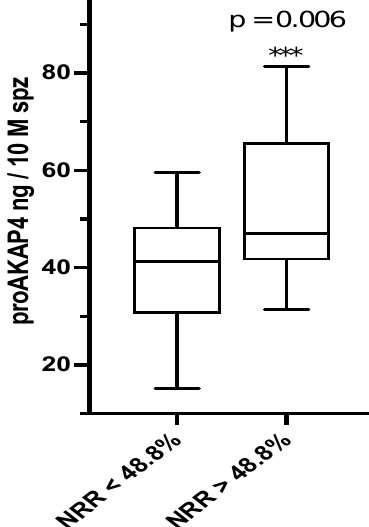
Figure 3. Correlation of linearity ( A ) and straightness ( B ) with proAKAP4 concentrations in post thawed bull semen. ( A ) Linearity ( B ) straightness of spermatozoa and concentrations of proAKAP4 in ng par 10 million of spermatozoa (ng/10 M spz).